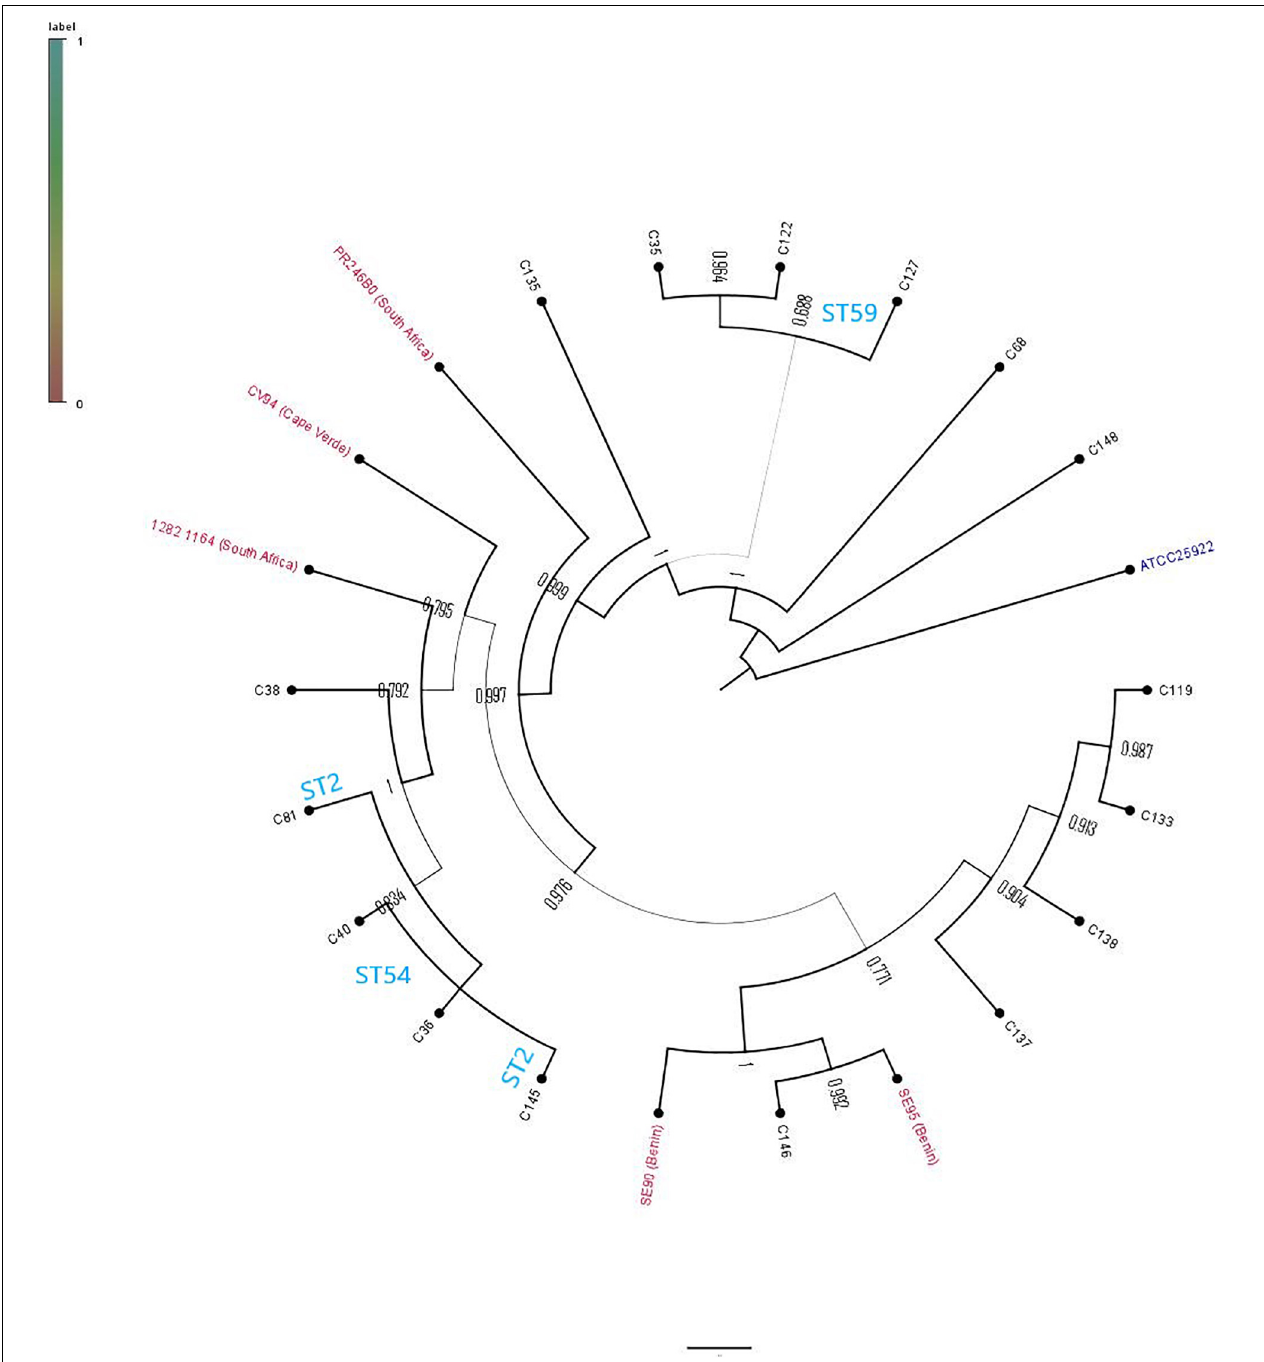
FIGURE 2 | Phylogenetic relationship of Staphylococcus epidermidis isolates in this study and African S. epidermidis (with their countries indicated) obtained from